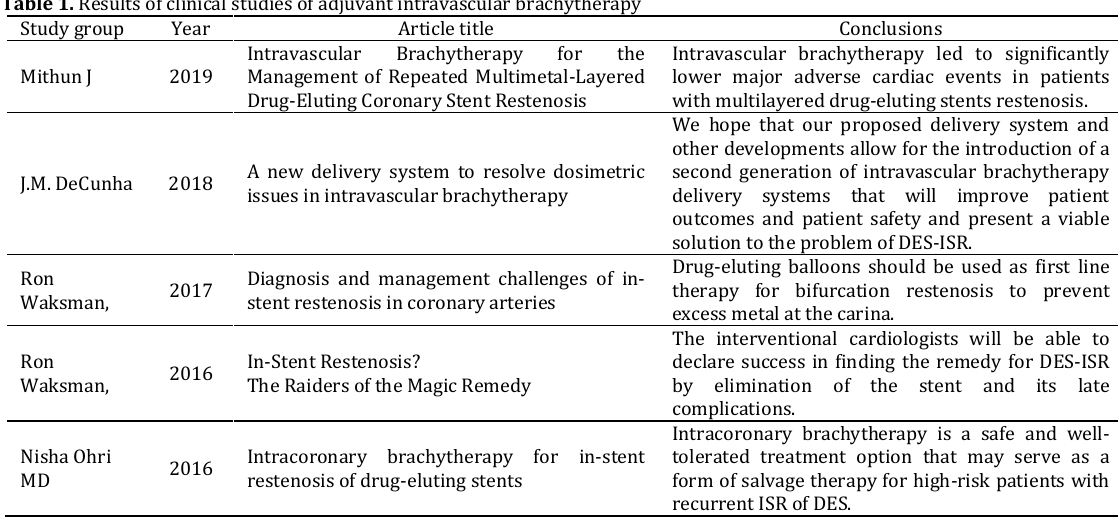
Results of clinical studies of adjuvant intravascular brachytherapy Study